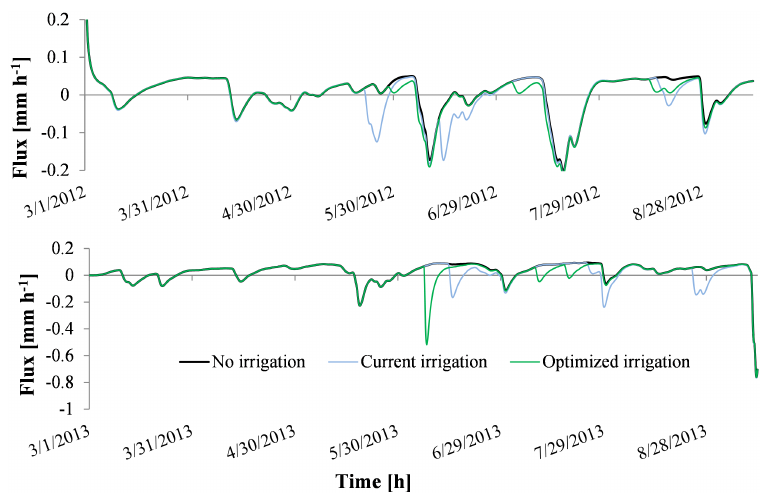
Figure 8. Actual flux of farmer’s conventional irrigation (current irrigation), without irrigation and optimized irrigation scheme (guided irrigation) for 2012 and